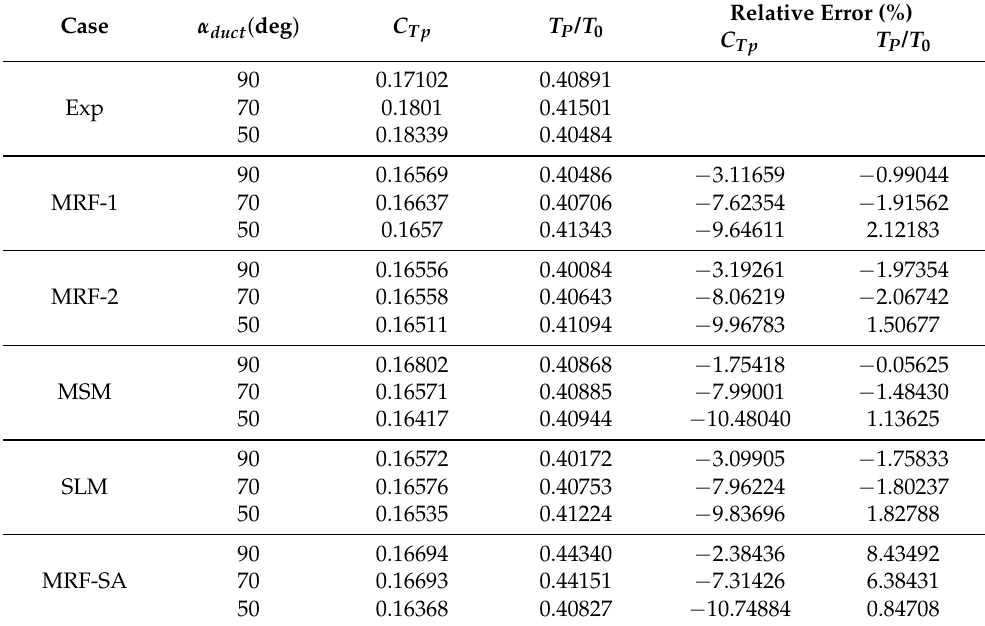
Table 1. The comparison between different